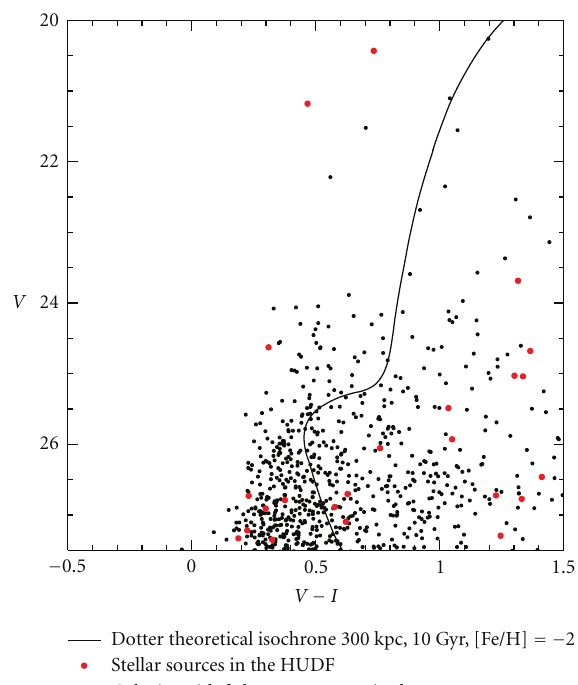
Figure 3: Color-magnitude diagram of galaxies with small angular sizes and stellar sources in the Hubble Ultra Deep Field [67]. Galaxies outnumber stellar objects by a factor of 75 in this figure, suggesting that unresolved galaxies will be the primary source of contamination in searches for ultra-faint dwarfs in deep survey data. Objects designated “stellar” in this image are those with type > 0 . 3 in the HUDF